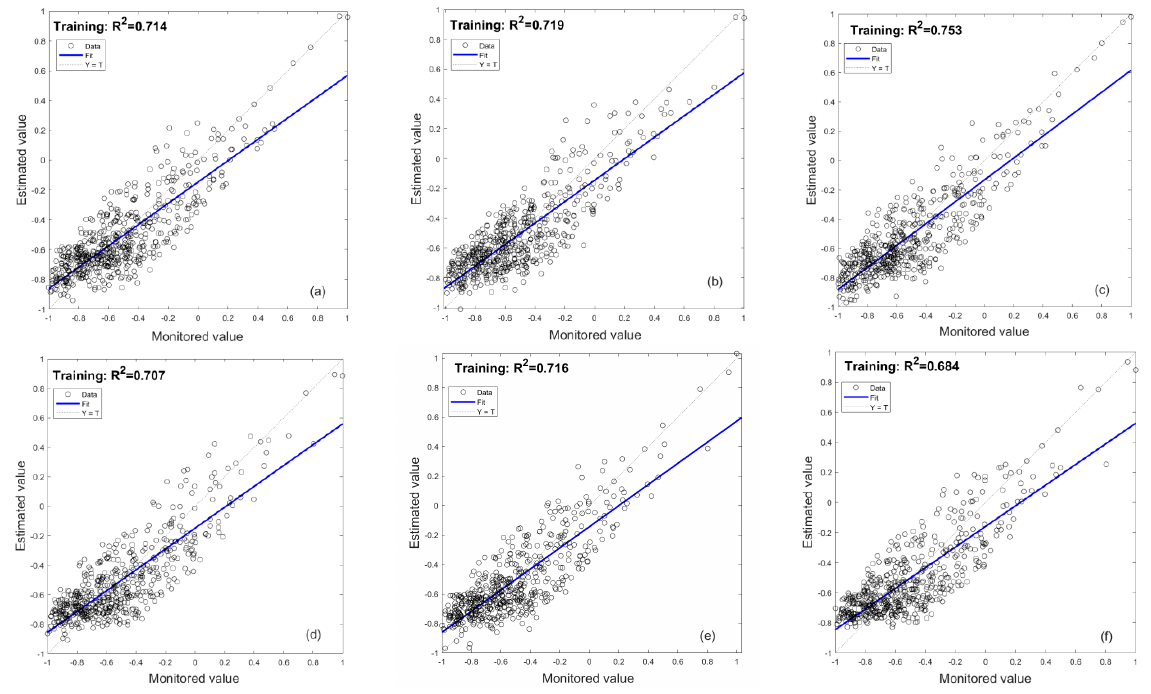
Figure 10. Estimated results of AOD + meteorological factors–PM 2.5 BPNN of training set ( a )–( f ).